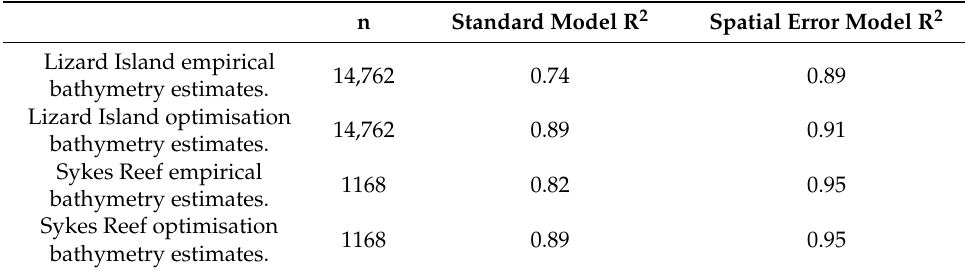
Table 3. Coefficient of determination values (R 2 ) of bathymetry estimates at Lizard Island and Sykes Reef derived from a standard and a spatial error model when compared to the validation echosounder data. n = the number of depth points used.